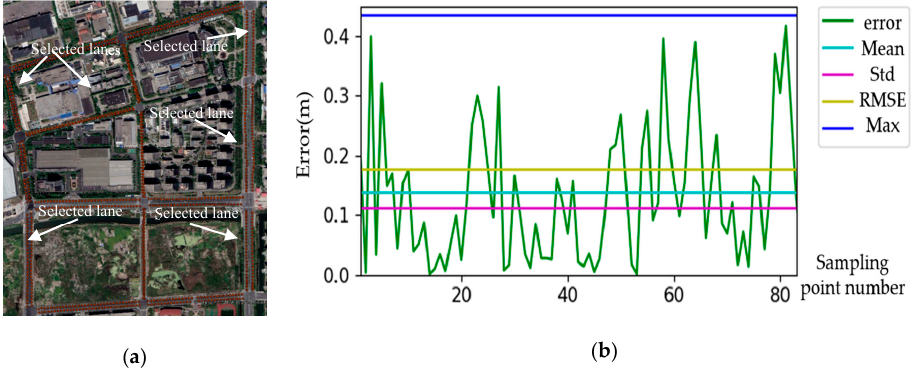
Figure 9. Experimental area and raw data: ( a ) GPS collection raw points; ( b ) accuracy assessment of original GPS trajectories. Note: Mean error (Mean), standard deviation error (Std), root mean square error (RMSE), and maximum error (Max).